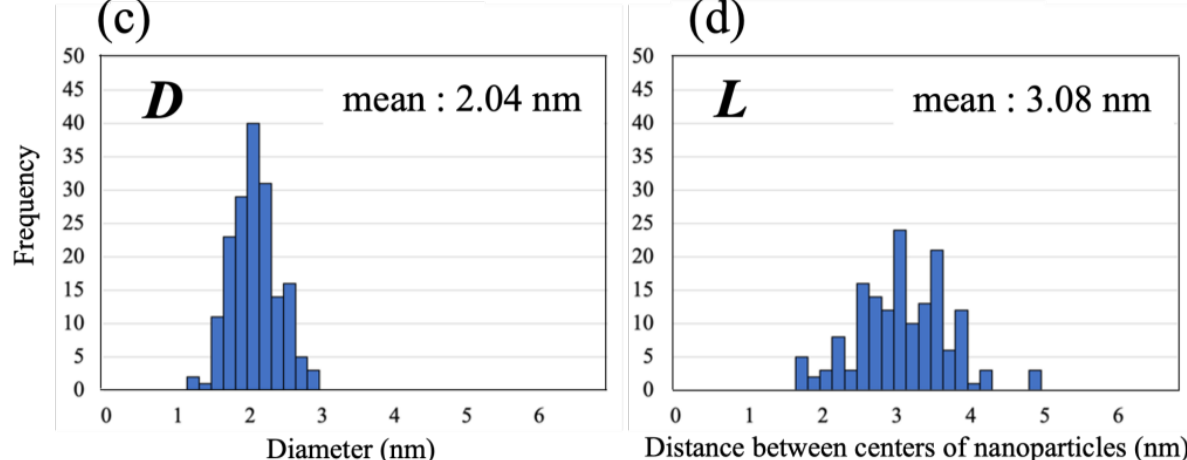
Figure 6. Histograms of ( a , c ) diameter, ( b , d ) distance between centers of nanoparticles. ( a ) and ( b ) are the results at HB:Ni = 100:0.5, ( c ) and ( d ) are the results at HB:Ni = 100:10.